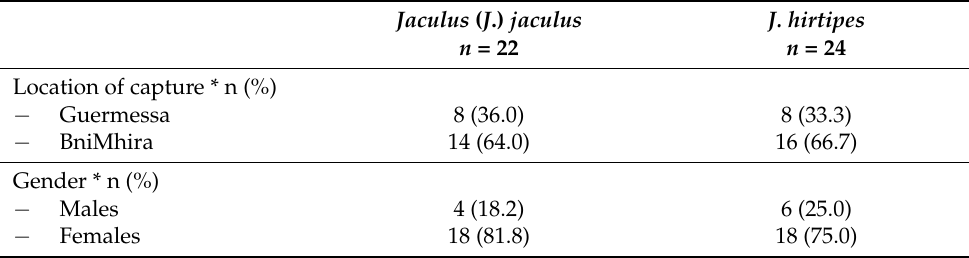
Table 1. Distribution of the captured rodents by location and